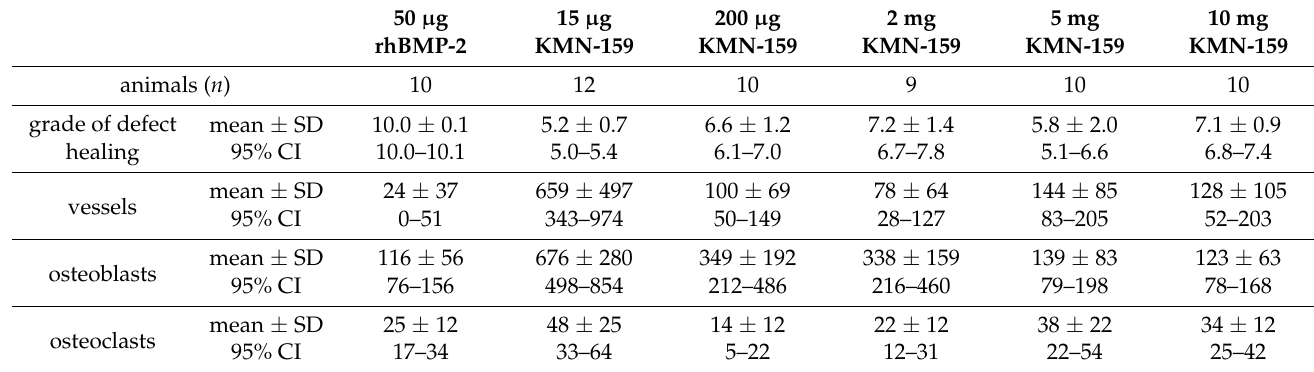
Figure 5. Histological evaluation of the degree of defect healing according to Huo et al. [23] 12 weeks after surgery (mean ± SD; Kruskal-Wallis following Dunn’s post hoc test: *** p < 0.001, ** p < 0.01). Table 3. Mean value, standard deviation (SD) and 95% confidence interval (CI) of the grade of defect healing (HE-staining) and the number of vessels ( α -smooth muscle actin staining), osteoblasts (ALPL staining) and osteoclasts (TSP staining) within the defect area 12 weeks